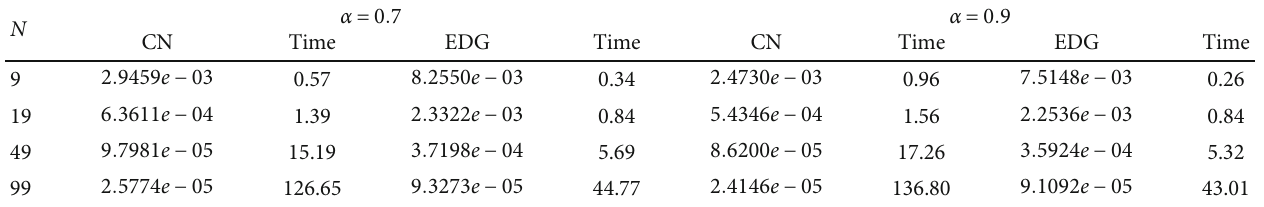
Table 4: Absolute errors of Example 14 at T = 1 for Re = 100 , Δ t = 0 : 01 , α = 0 : 7 , and α = 0 : 9 .